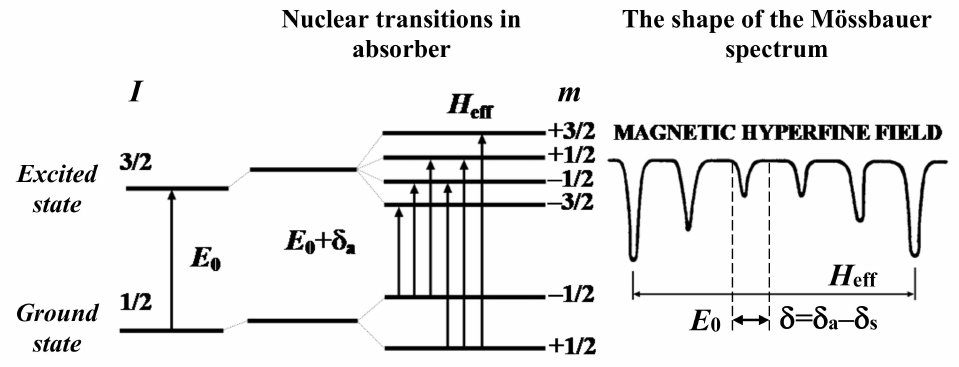
Figure A7. Scheme of the nuclear electric monopole and magnetic dipole interactions, isomer shift 57 Fe, resonance transitions and resulting shape of the δ and magnetic hyperfine field H eff for the Mössbauer spectrum. I is a nuclear spin, m is a magnetic quantum number.